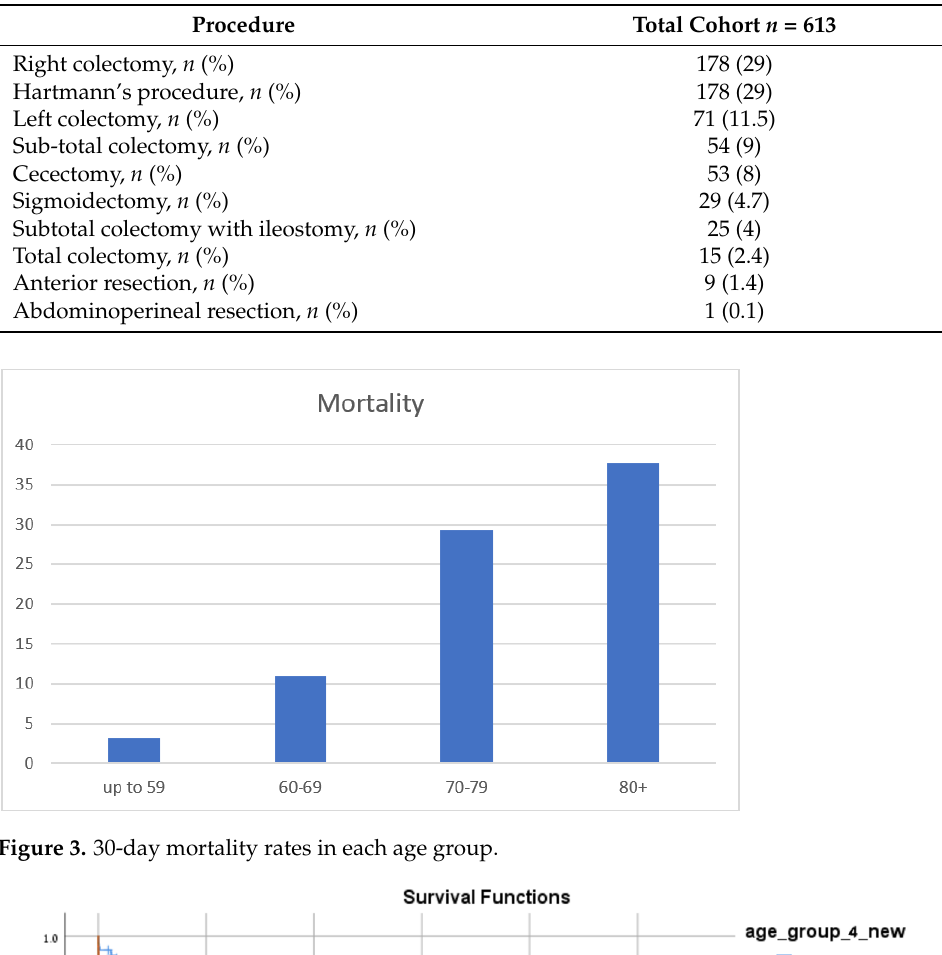
Table 1. Total procedures performed.